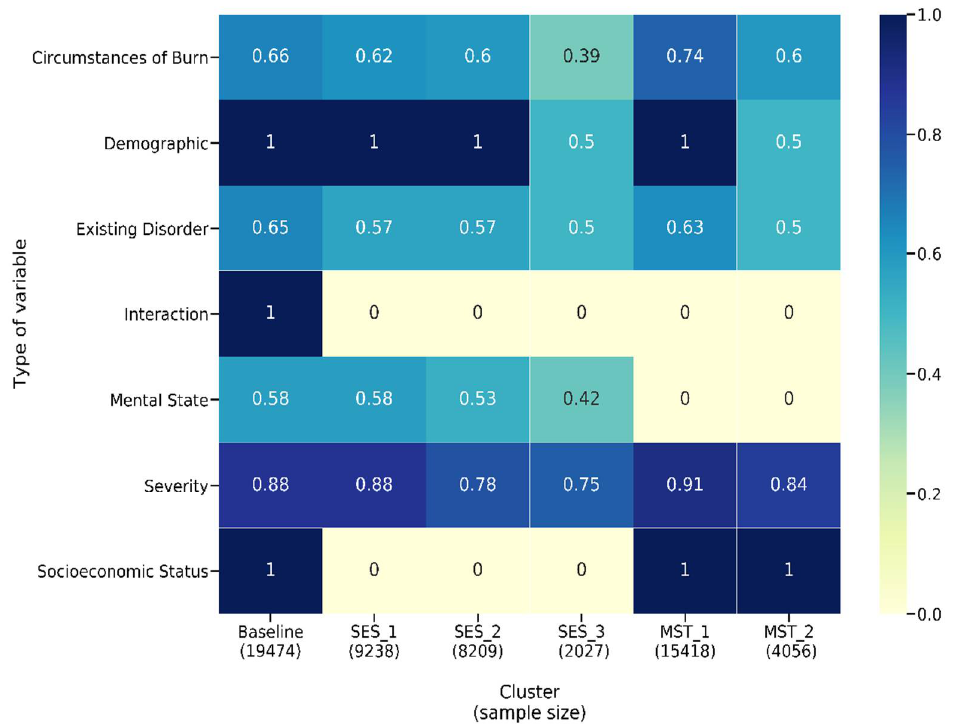
Figure 6. Heatmap showing the proportion of variables that have a nonzero coefficient in each type for MST-based, SES-based and unitary models.